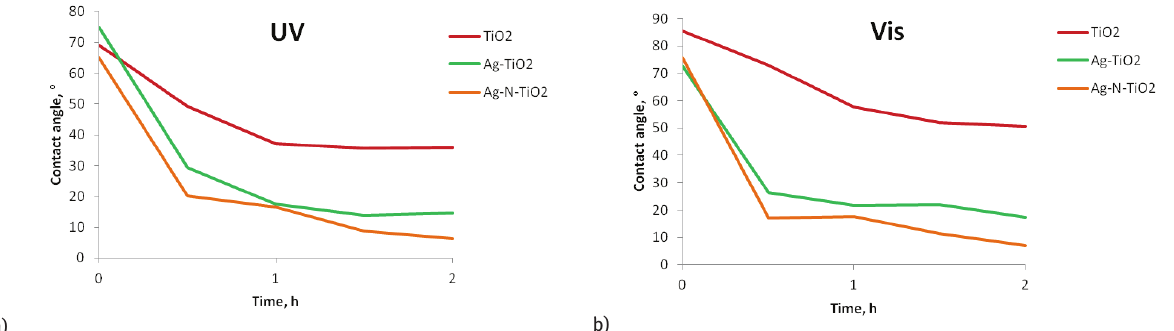
NPs, Ag-TiO NPs, Ag-N-TiO NPs and exposed to UV (a) and visible 2 2 2